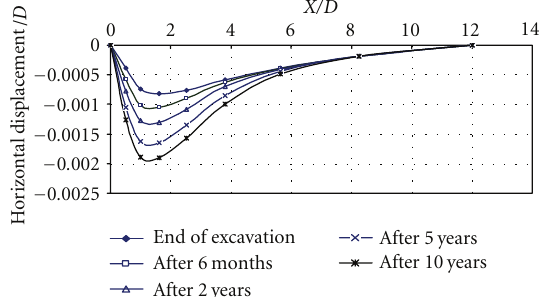
Figure 21: Variation of surface settlement depending on variation of k 0 .